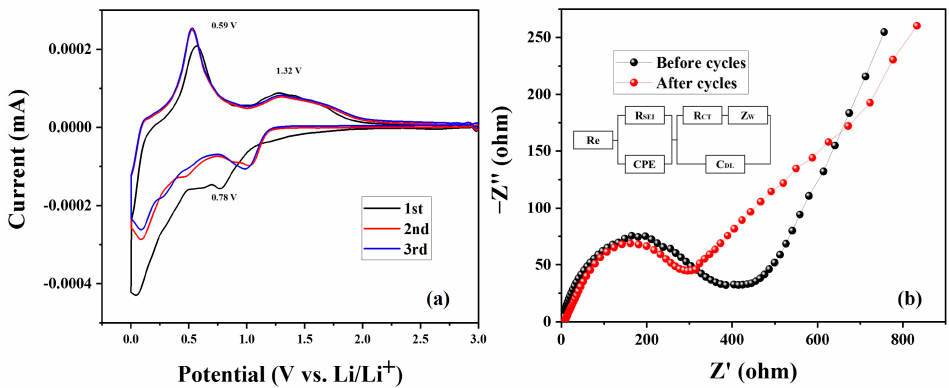
Figure 10. ( a ) Cyclic voltammograms (CV) curves and ( b ) electrochemical impedance spectra (EIS) of SnO2-CNFi electrode before and after 50 cycles.